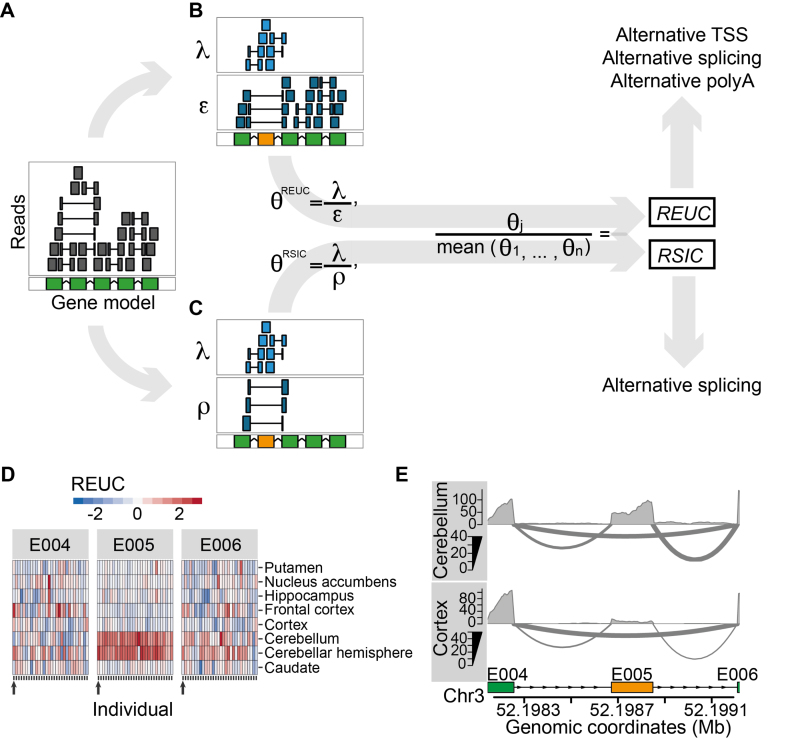
Quantification of exon usage. (A) Exemplary gene model in the reference genome (green) and alignments of RNA-seq reads (upper panel). Sequenced fragments whose alignments fall fully into an exonic region are shown by a gray box; alignments that map into two (or more) exonic regions are shown by shorter gray boxes connected by a horizontal line. For a particular exon (highlighted in orange), we consider two strategies to quantify its usage, as illustrated in Panels (B and C) (see ‘Materials and Methods’ section for the formal description). The first strategy is illustrated in Panel B, where sequenced fragments are counted into two groups: those that map fully or partially to the exon (λ) and those that map to the rest of the exons (ϵ). θREUC is defined as the ratio between λ and ϵ, and the REUC for the exon in sample j is computed as the ratio between θREUC in that sample to the mean θREUC across all samples. Panel C illustrates the second strategy, where sequenced fragments are also counted into two groups: those that map fully or partially to the exon (λ) and those that align to exons both downstream and upstream of the exon under consideration (ρ). The latter represent transcripts from which the exon was spliced out. θRSIC is then defined as the ratio between λ and ρ. The relative spliced-in coefficient (RSIC) for the exon in sample j is the ratio of θRSIC in this sample to the mean θRSIC across all samples. Note that while differences in exon usage due to alternative splicing are reflected in both REUCs and RSICs, differences due to alternative transcription or termination are only reflected in REUCs. (D) Heatmap representations of the REUCs for three exonic regions (E004, E005 and E006) of the gene 5-Aminolevulinate Synthase 1, computed using subset A of the GTEx data. The rows of the heatmaps correspond to the eight tissues, and each column corresponds to one individual. The horizontal color patterns of exon E005 indicate elevated inclusion of cerebellum and cerebellar cortex as compared to the rest of the brain cell types. (E) RNA-seq samples from two cell types (cortex and cerebellum) from individual 12ZZX (also indicated by the arrows below each heatmap in Figure 1D) are displayed as sashimi plots. The three exonic regions presented in Panel D are shown. The middle exon, E005, is an untranslated cassette exon (ENSEMBL identifier ENSE00002267562) that is spliced out more frequently in cortex than in cerebellum.